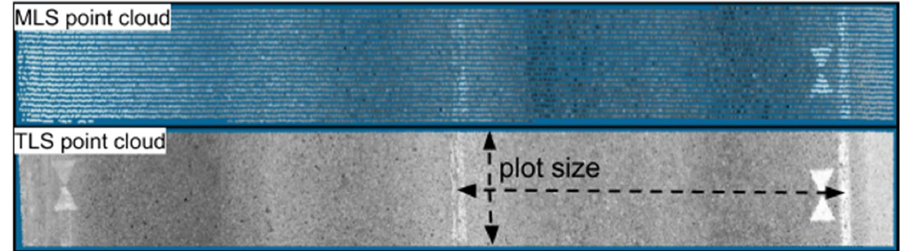
Figure 6. MLS ( above ) and TLS ( below ) point clouds from the plot area (Plot 2). Here, the scanner was located on the right lane in both cases. The right lane was therefore the studied plot area.